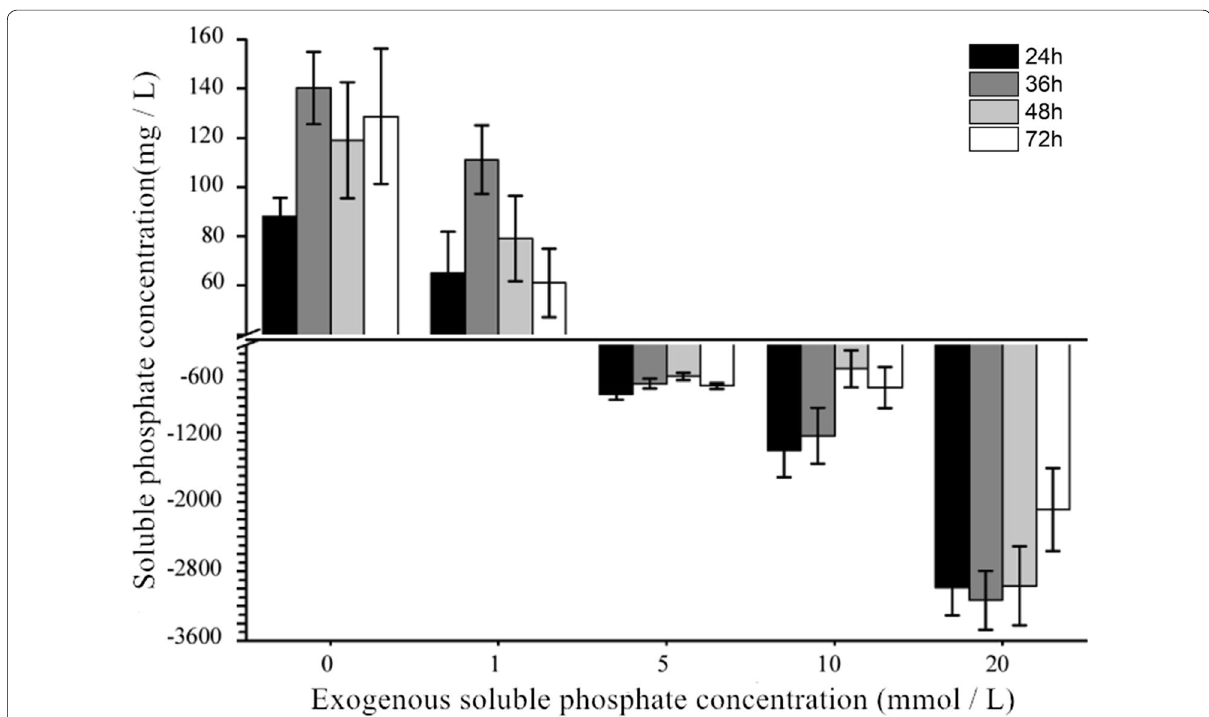
Fig. 3 Detection of the phosphate‑solubilizing ability of Burkholderia multivorans WS‑FJ9 under different soluble phosphate levels